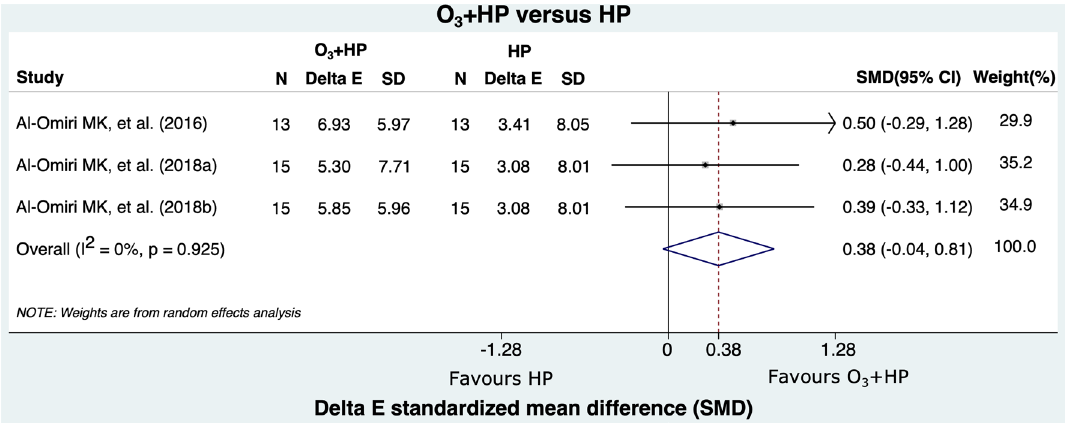
Figure 3. Forest plot of color change comparing group HP + O 3 to group